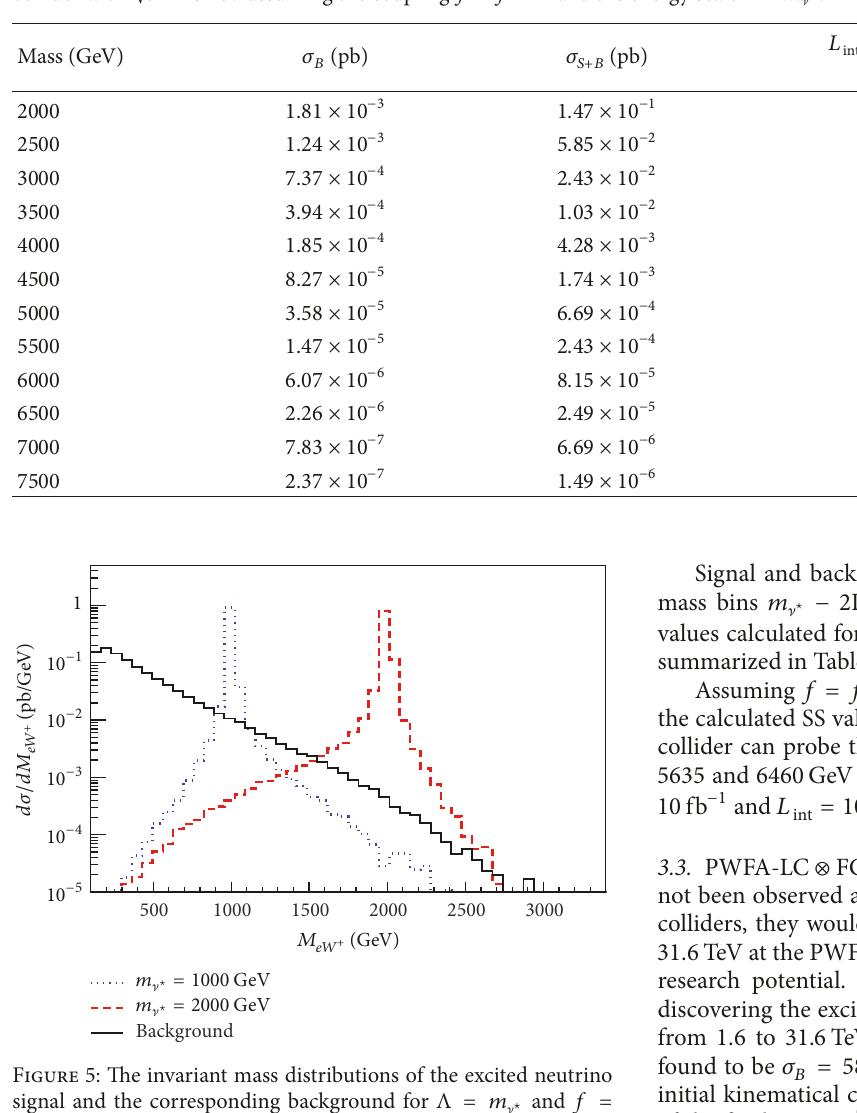
the excited neutrinos in the mass range from 1.6 to 10